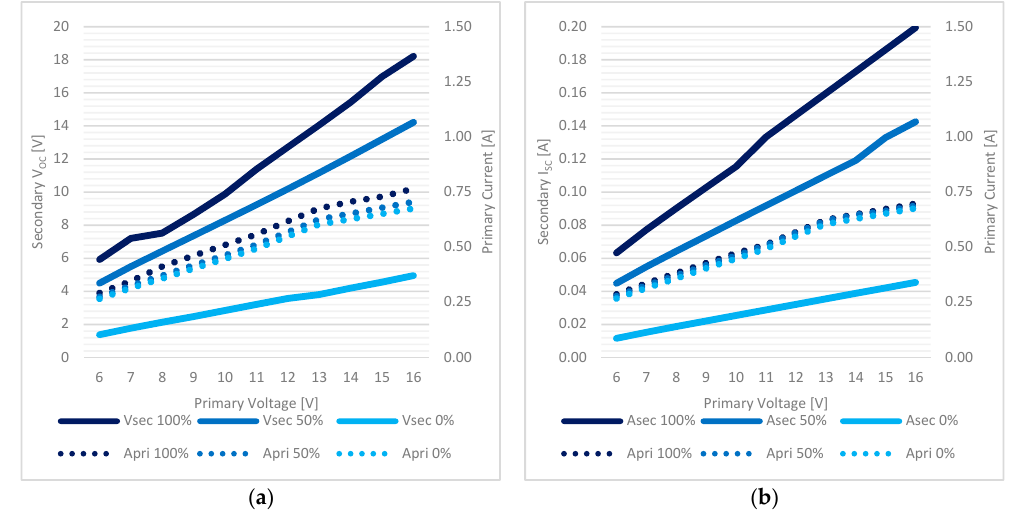
Figure 14. Inductive charging system characterization, concrete environment: ( a ) V OC , ( b ) I SC .